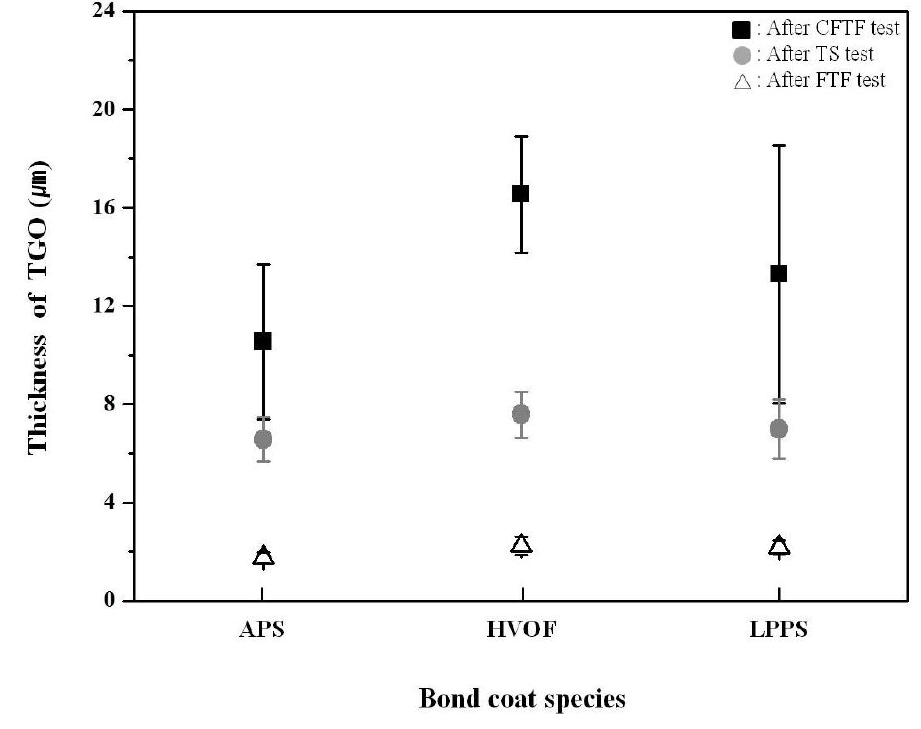
Figure 9. Thickness of thermally grown oxide (TGO) layer with bond coat species after different thermal exposure tests. Black, gray, and white marks indicate the TGO thickness values after the CFTF, TS, and FTF tests,